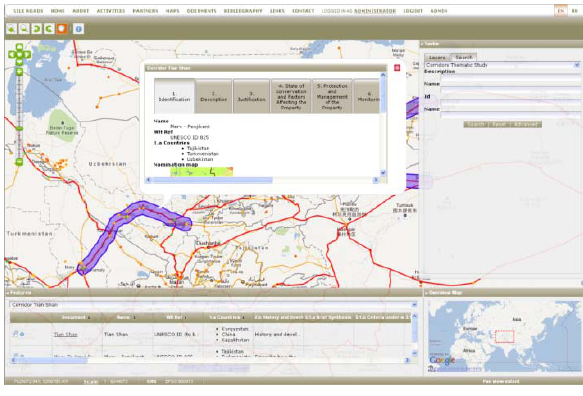
Figure 2: Corridor map © Silk Roads CHRIS.